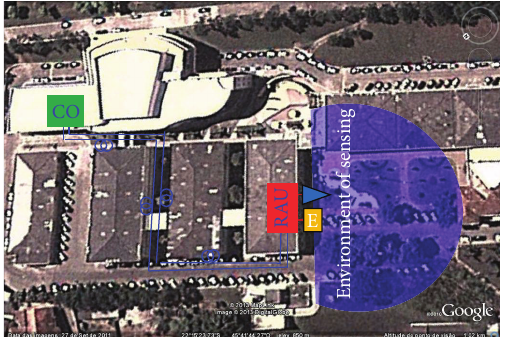
Figure 8: Google Earth image of the implemented real optical- wireless network.